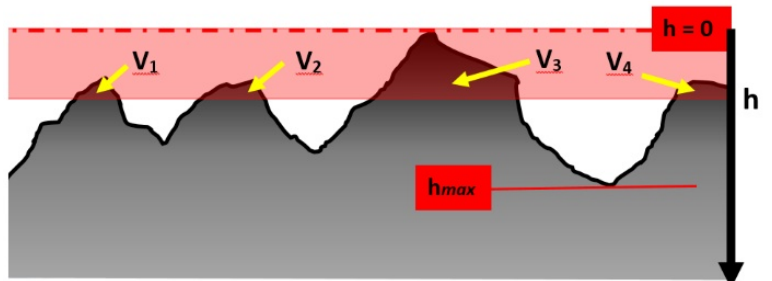
Figure 17. Explanation of proposed method of characterization of pavement texture in respect to rolling resistance.